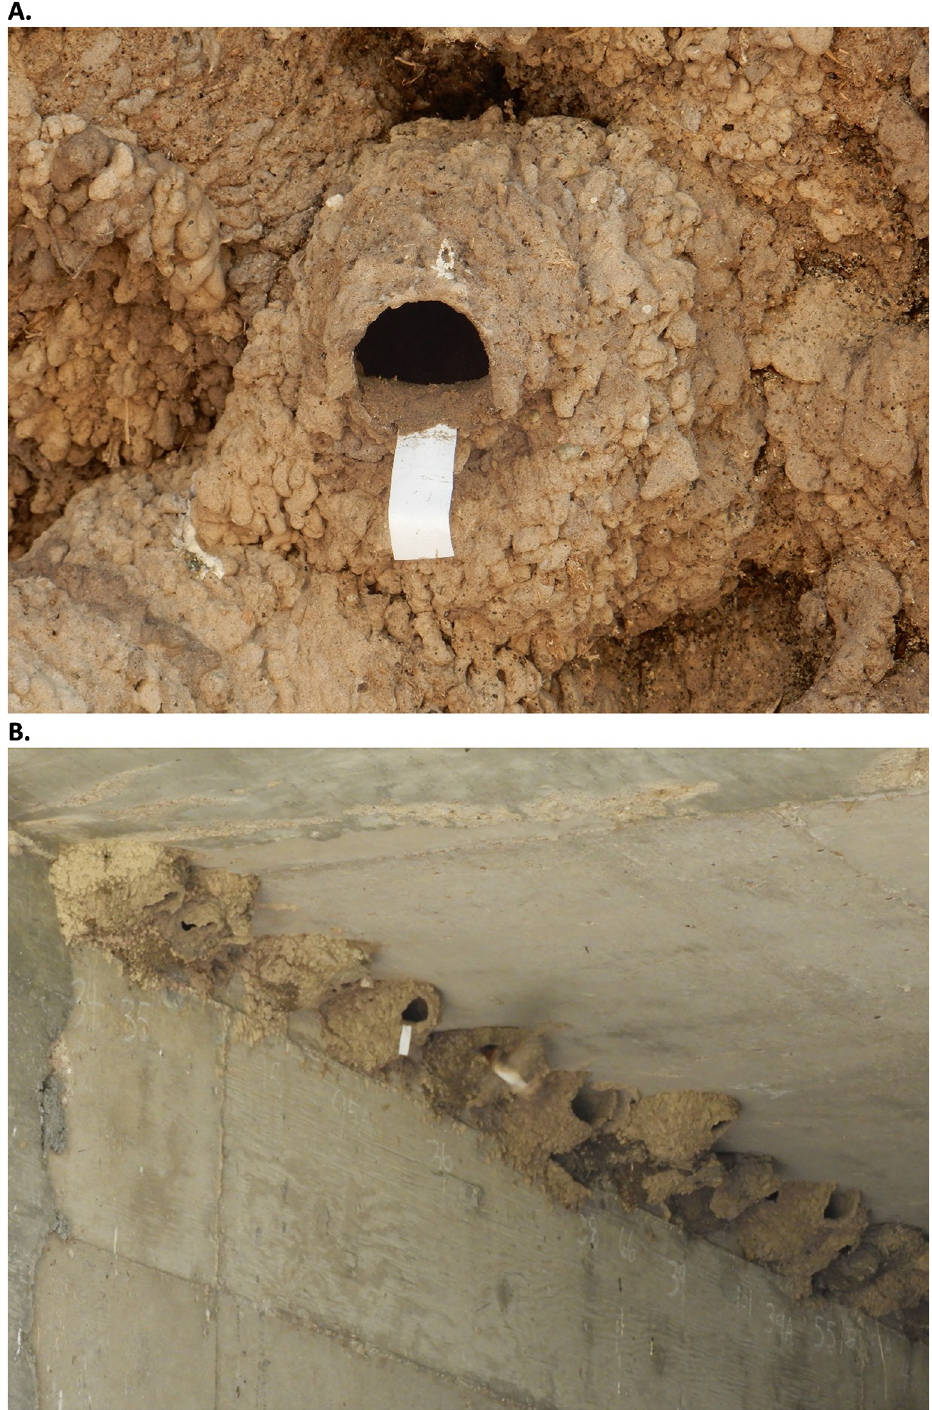
Fig 2. Marking tape (novel object) placement on a cliff swallow nest as used in neophobia trials measuring latency to enter nest and number of attacks. (A) Marking tape on a nest and (B) a cliff swallow hovering to the right of its